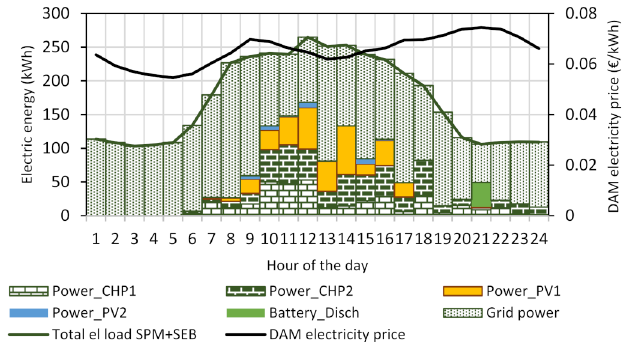
Figure 25. Electrical energy balance of the ILEC obtained with stochastic economic optimization for the representative summer